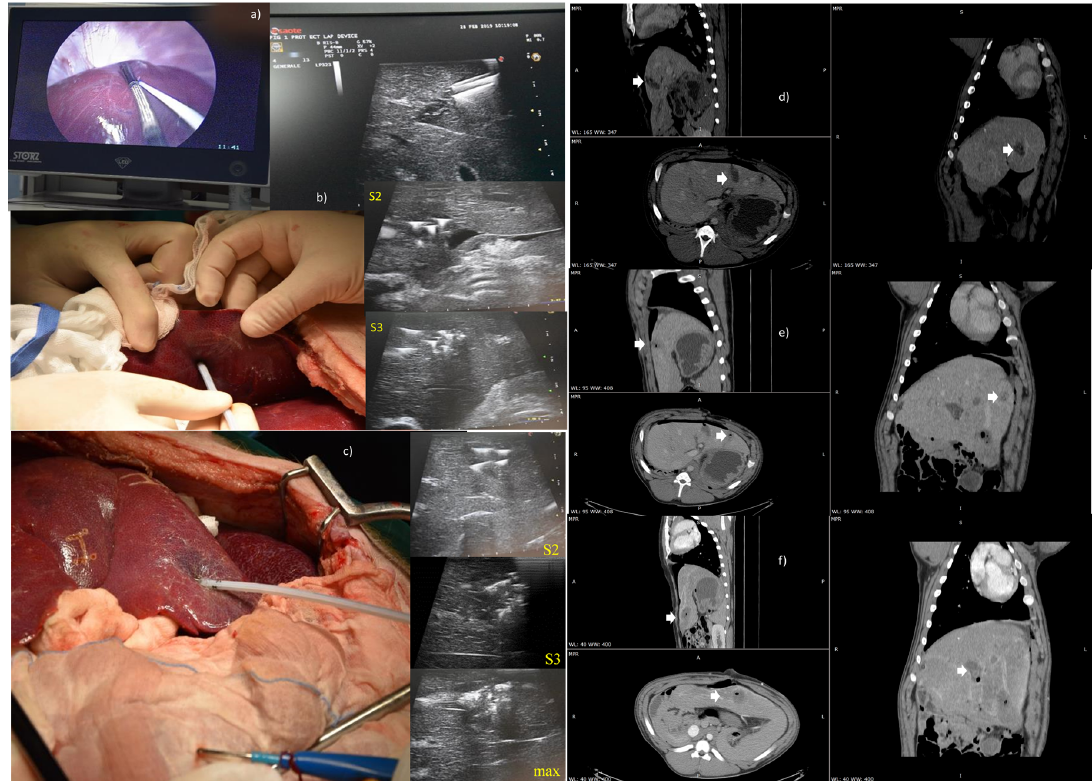
Figure 4. ( a ) Treatment performed by the laparoscopic access and ultrasound images used as a guide for the insertion of a 5-needle expandable electrode with zero divergence; ( b ) treatment in open